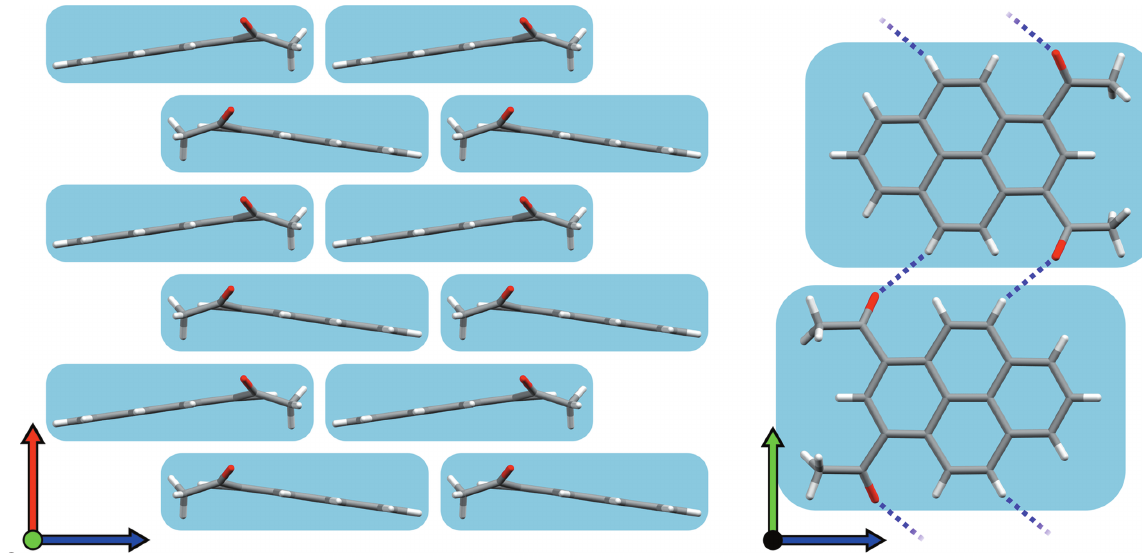
Figure 8 Crystal packing featured in the 2 (cid:2) AP- (cid:2) family observed from y and x . Left: offset stacks of 2 (cid:2) AP molecules interlocked, creating brick-layer motifs in the xz plane. Right: neighboring brick-layers interact in the y direction via double hydrogen bonds on each side of each